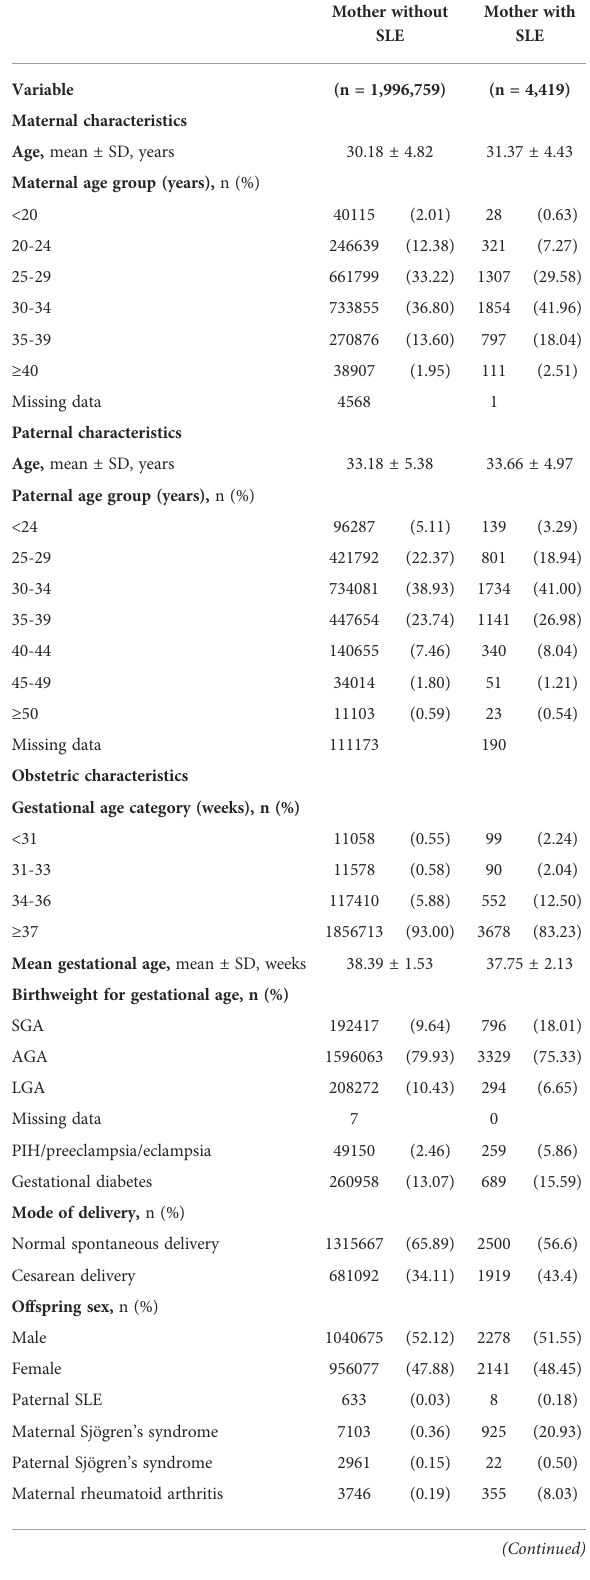
TABLE 1 Baseline characteristics of mothers with and without SLE and their singletons born between 2004 and 2015 identi fi ed in the